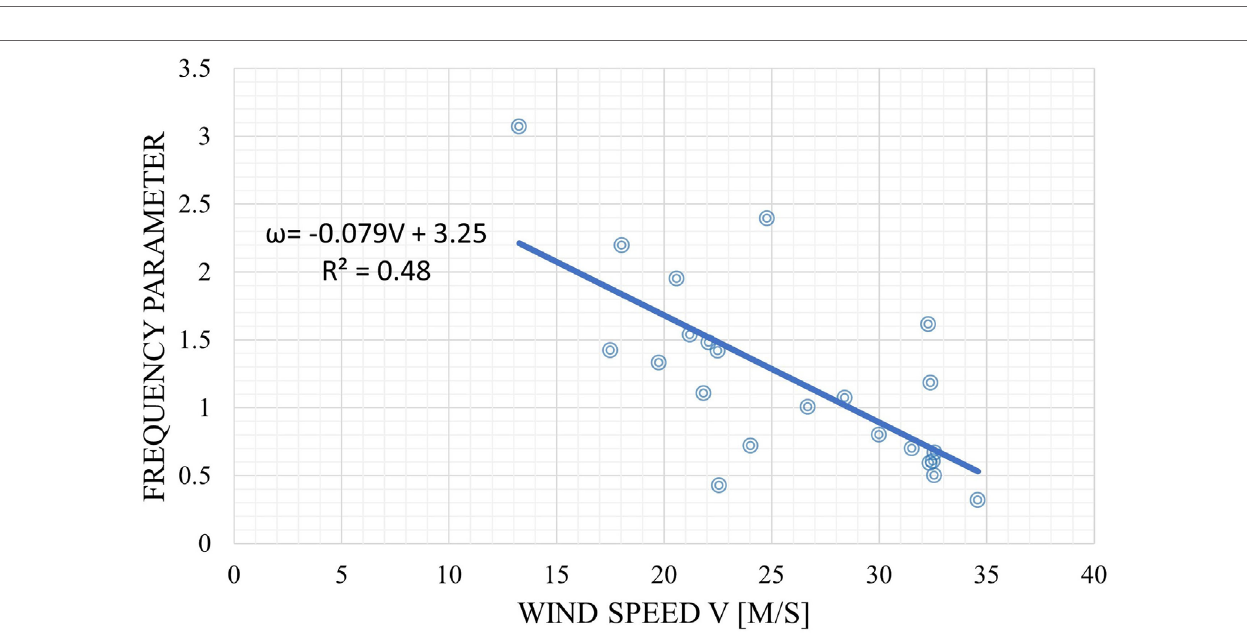
FigUre 6 | The relationship between the parameters VUL and X 0 for hurricane data at three spatial scales.